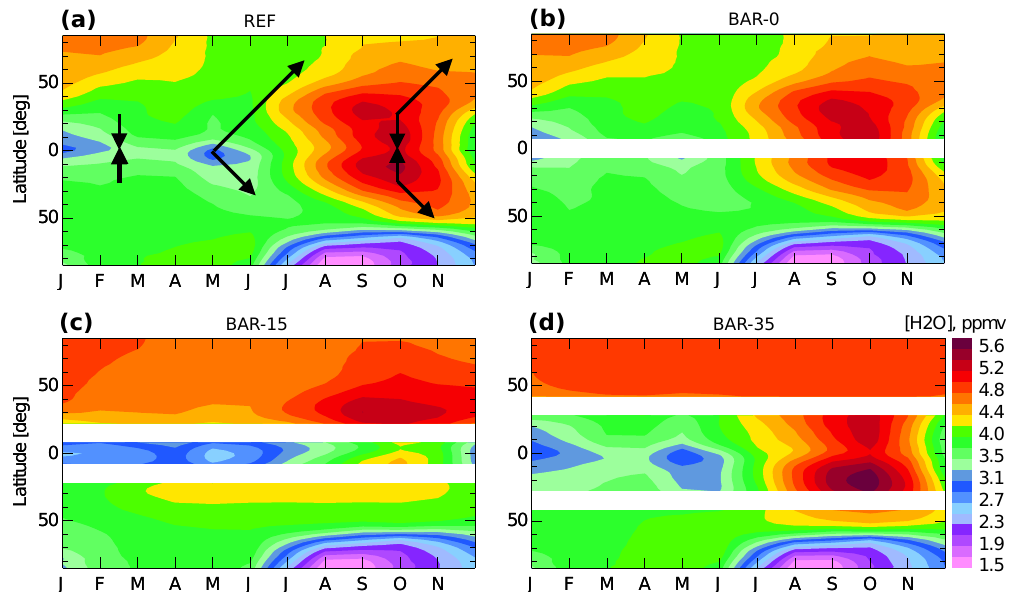
Figure 10. Horizontal tape recorder of water vapour at the potential temperature level θ = 400K for 2011. Shown data are from CLaMS sensitivity simulations for the reference (a) and the sensitivity simulations with transport barriers along latitude circles at 0 ◦ (b) , 15 ◦ N/S (c) and 35 ◦ N/S (d) . Transport barriers are represented in white, and the main directions of air mass transport are presented with black